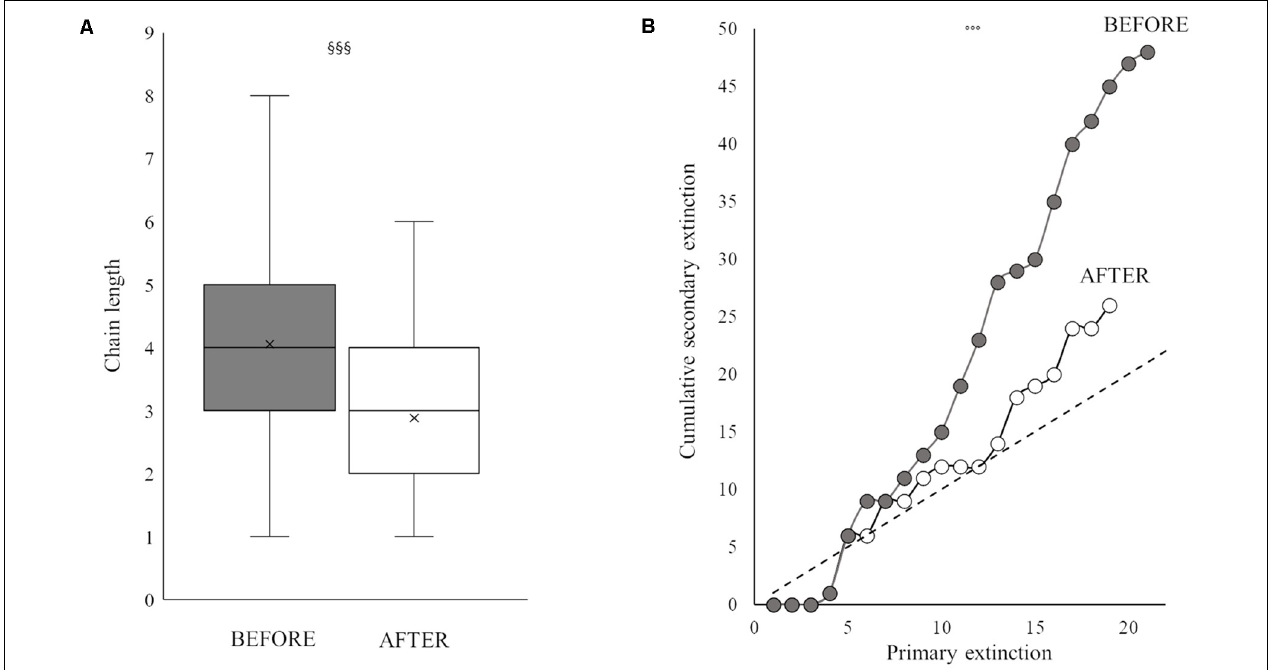
FIGURE 5 | Box plot of mean chain length (A) and robustness trend (primary extinction against cumulative secondary extinction) (B) BEFORE (gray) and AFTER (white). Superscript symbols ( and ◦ ) indicate a significant difference between periods (see also “Results” section). One, two and three superscript symbols indicate p values of < 0.05, < 0.01, and < 0.001,